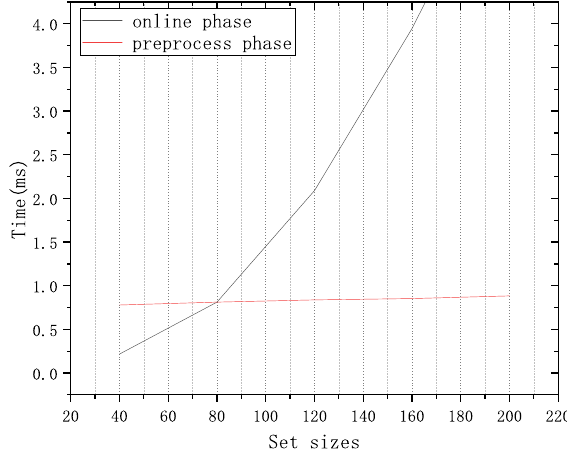
Figure 6. The time of the STLPSI protocol under different set